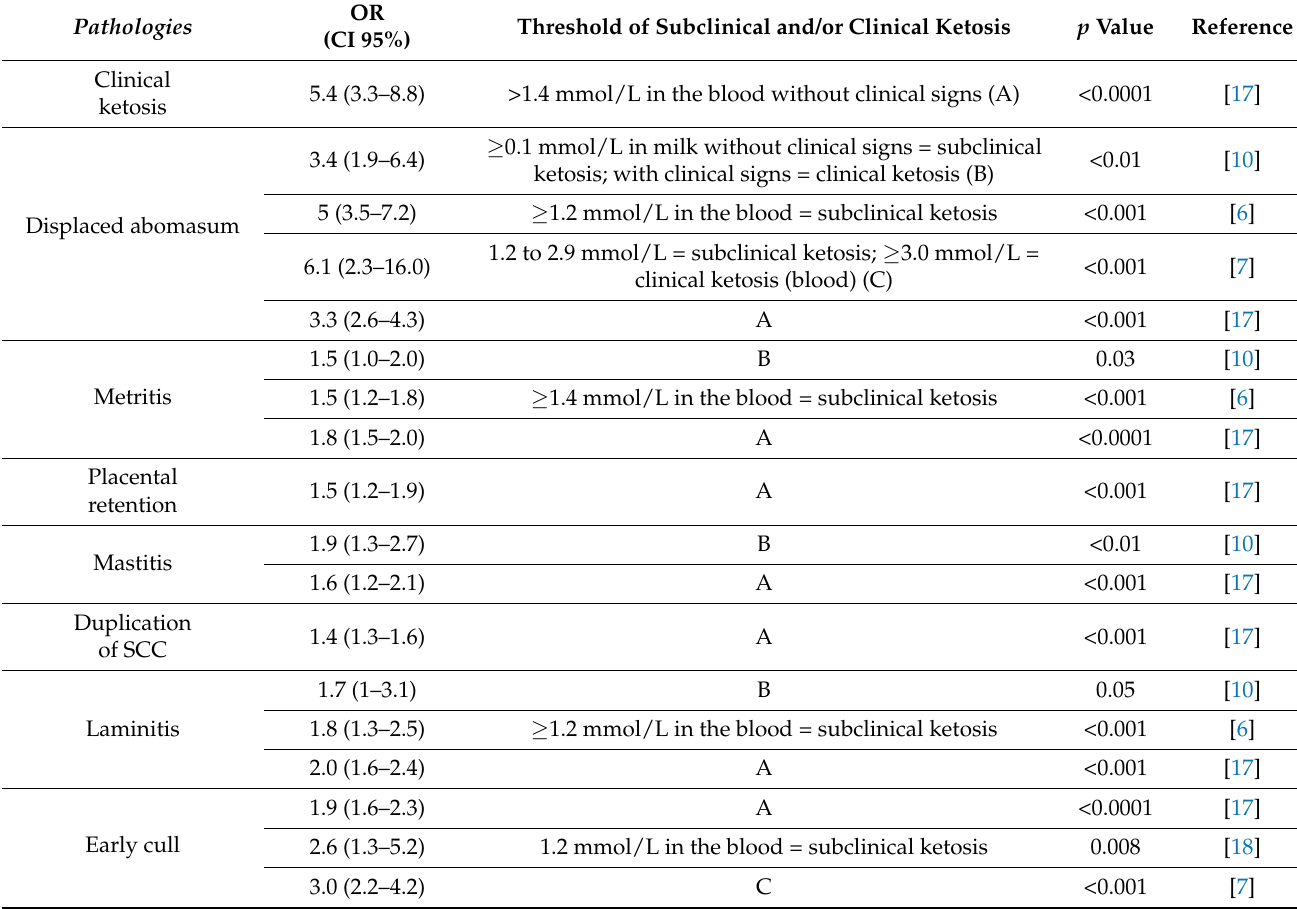
Table 3. Likelihood (odds ratio) of dairy cows to present different pathologies during